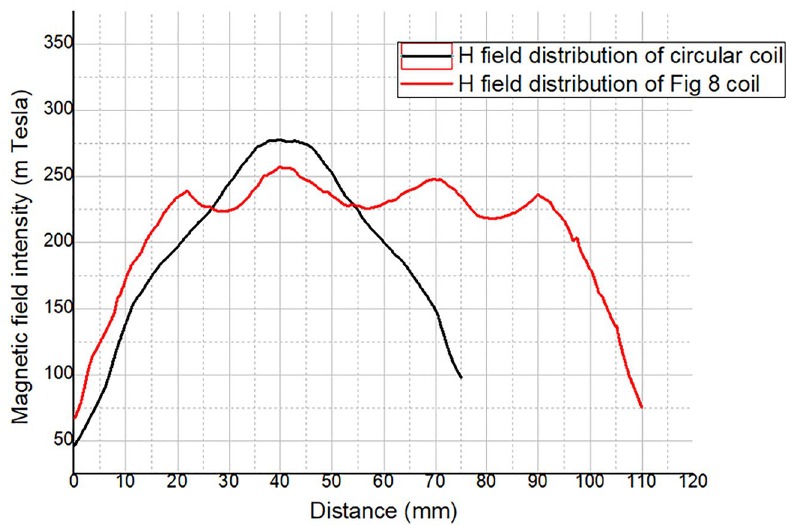
Figure 7. Graphical comparison of magnetic field intensity and pattern of circular coil and figure-8 shaped coil.